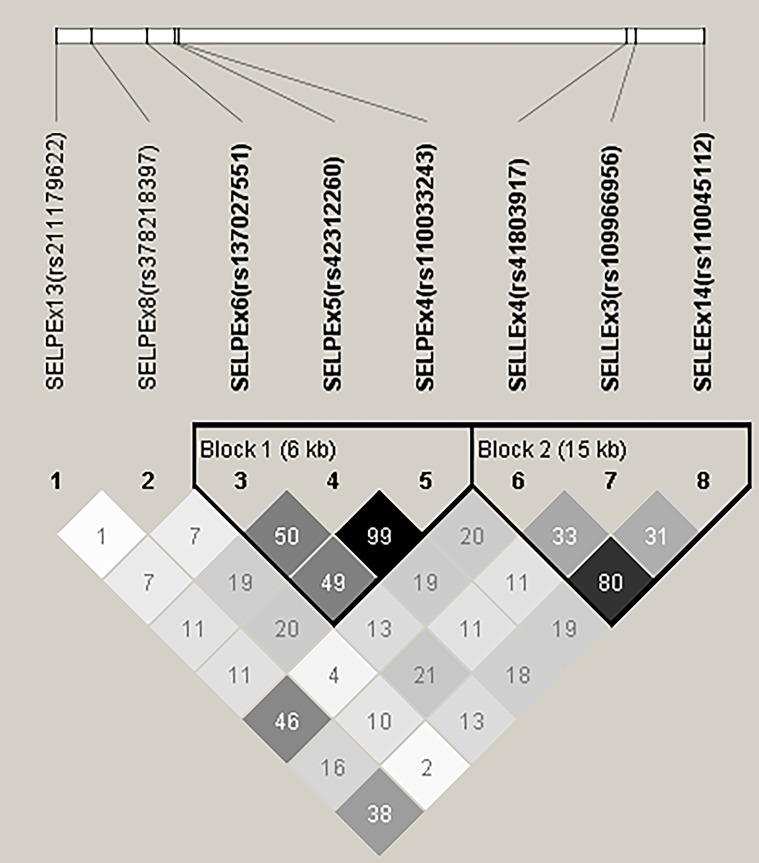
Linkage disequilibrium map for SNP in bovine selectin genes.Each SNP is represented by a grey triangle labelled 1 to 8, with their location on the chromosome shown above. The square in which the columns leading from two SNP intersect shows the correlation between them (r2 x 100), with darker shading representing higher correlation. The haplotype blocks represent SNP that are in high linkage disequilibrium with each other and thus are all generally inherited together.